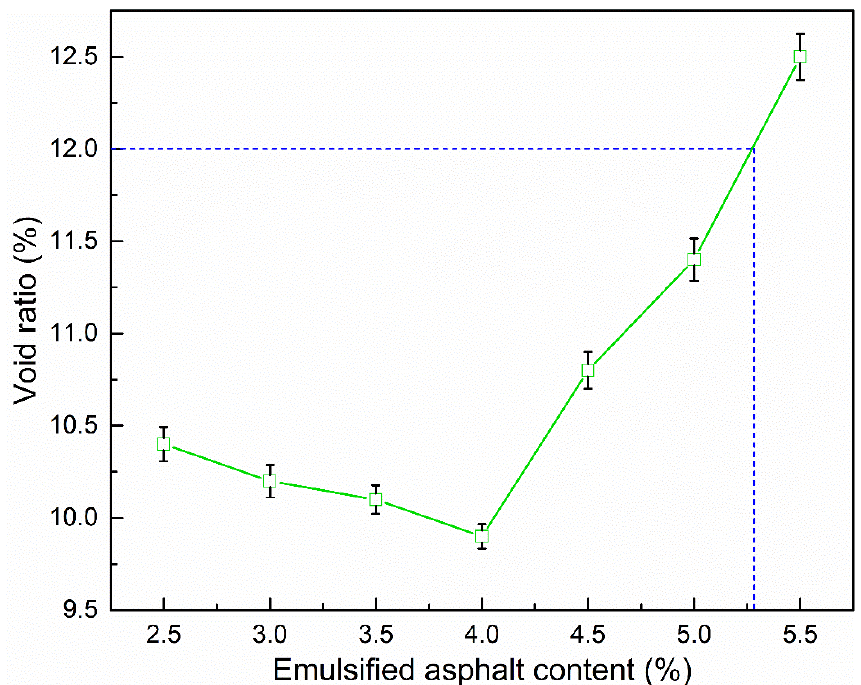
Figure 7. Influence of emulsified asphalt content on void ratio.